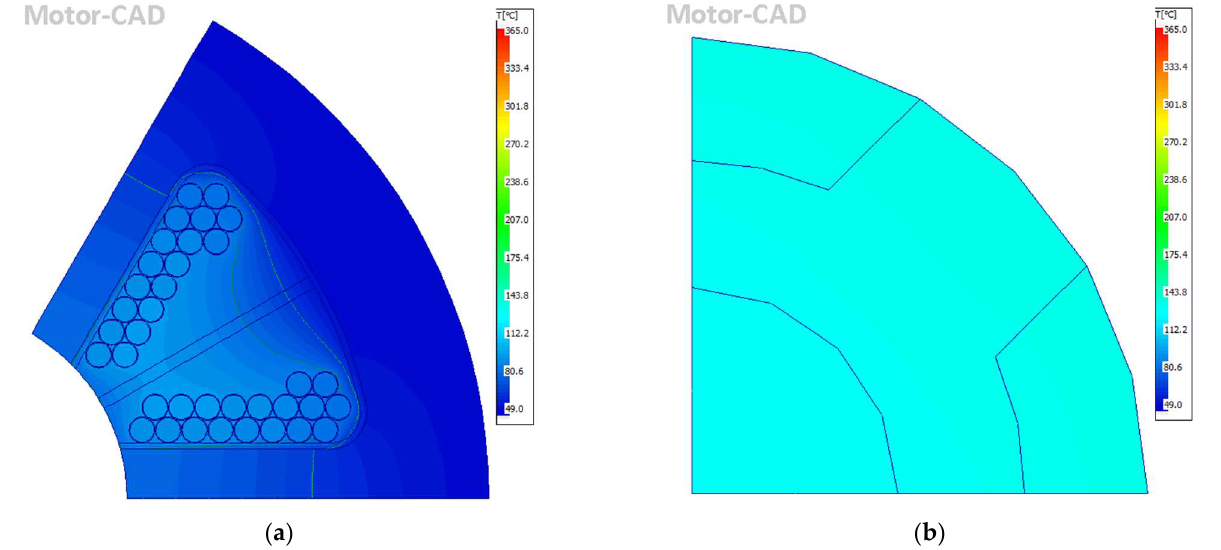
Figure 18. The distribution of temperature at steady state of the final design: ( a ) stator; ( b ) rotor.